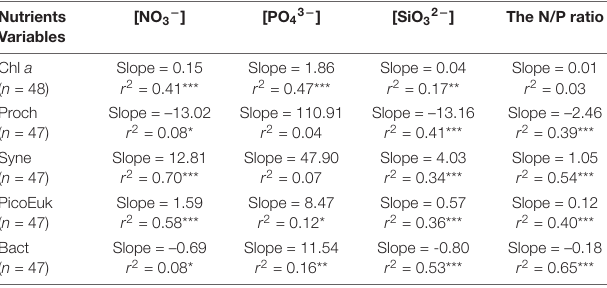
TABLE 2 | The slopes, r 2 and p -values of linear regressions between the depth-integrated values of variables vs. nutrient concentrations ( µ M) [e.g., nitrate (NO 3 − ; N), phosphate (PO 43 − ; P), silicate (SiO 32 − )] or the N/P molar ratio for the upper 100 m depth of all sampling